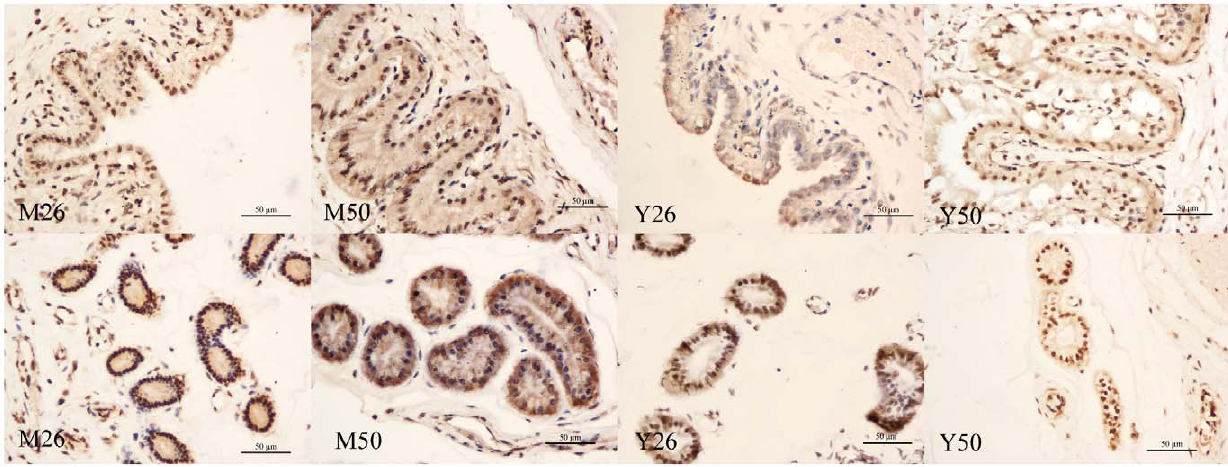
Figure 4. IHC analysis of porcine NNAT in the placenta using rabbit anti-NNAT. Stroma (S) represented the maternal side and fetal chorion (C) represented the fetal side. L: Luminal epithelium; G: glandular epithelium. All images were obtained at 40 6 magnification. Scale bars represented 50 m m.